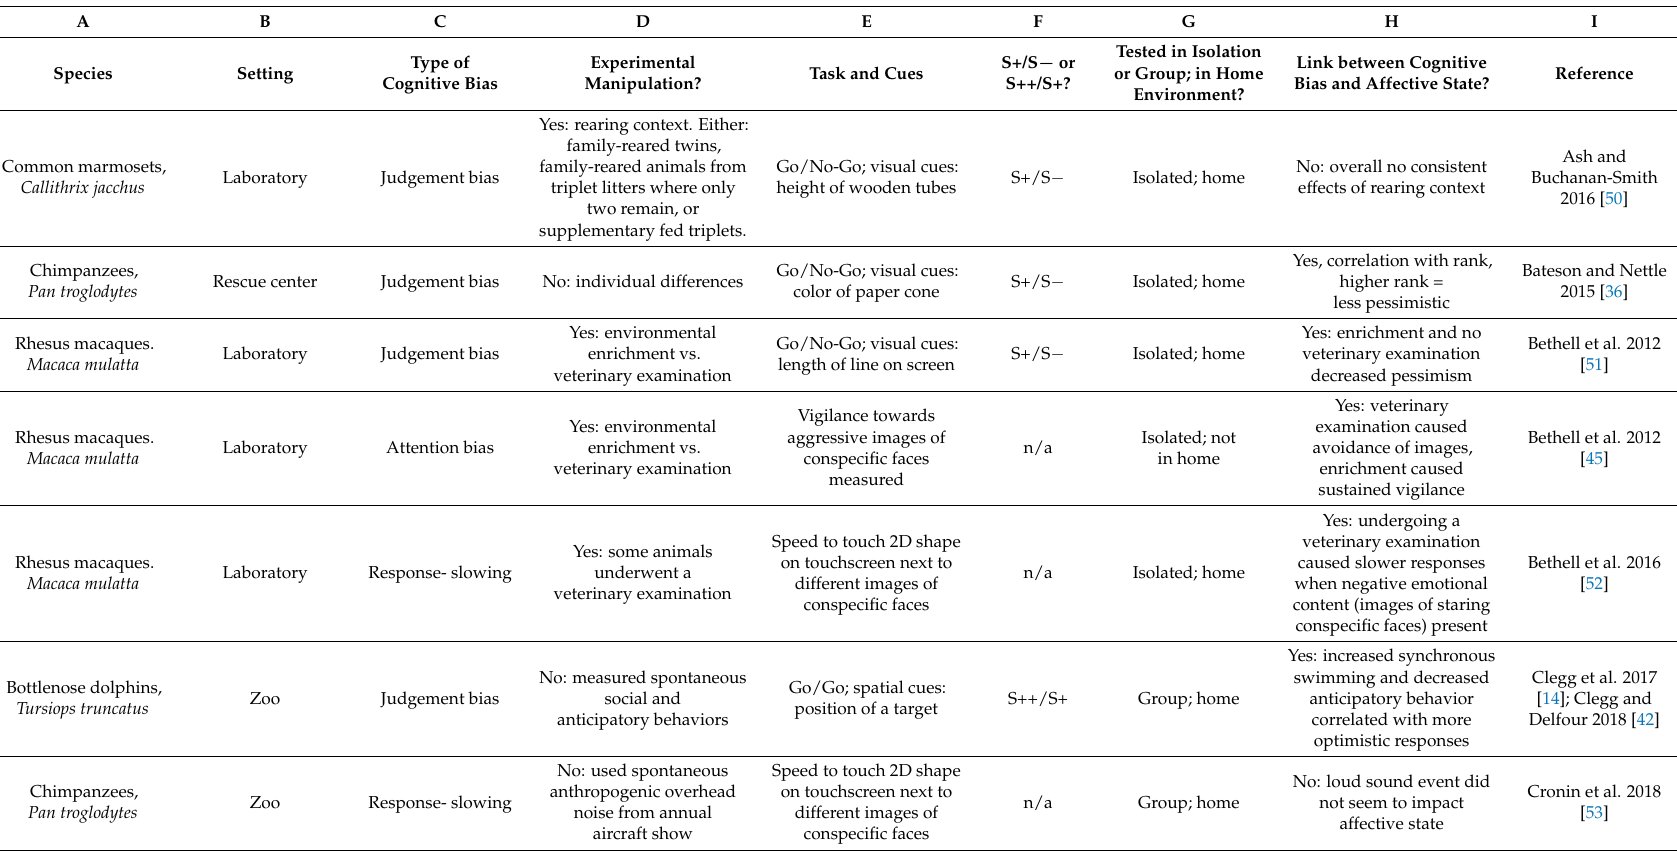
Table 1. Published cognitive bias studies conducted in zoo environments, and those carried out in other settings but involving non-domesticated, “exotic” species often kept in zoos; adapted from [13]. D: was the animal’s affective state altered experimentally as part of the design, or were bias results correlated with spontaneous mood states? E: what type of task and cues were used? F: was negative reinforcement/punishment used for differentiating the conditioned cues (S+/S − ), or was positive reinforcement used (S++/S+)? G: were the subjects socially isolated, and tested in their home environment? H: was the null hypothesis (H 0 ) rejected, i.e.,